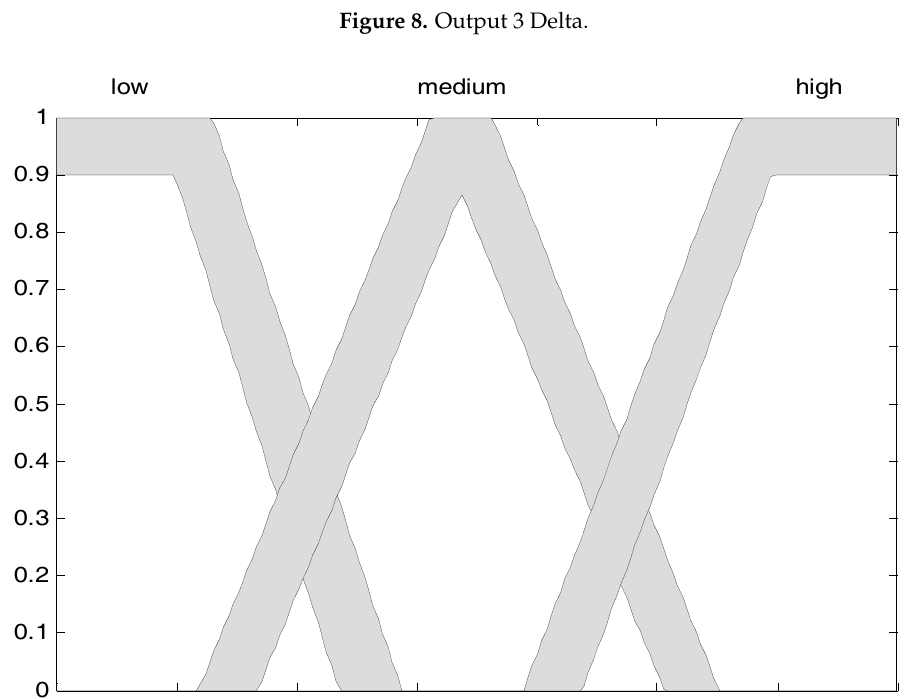
Figure 8. Output 3 Delta.